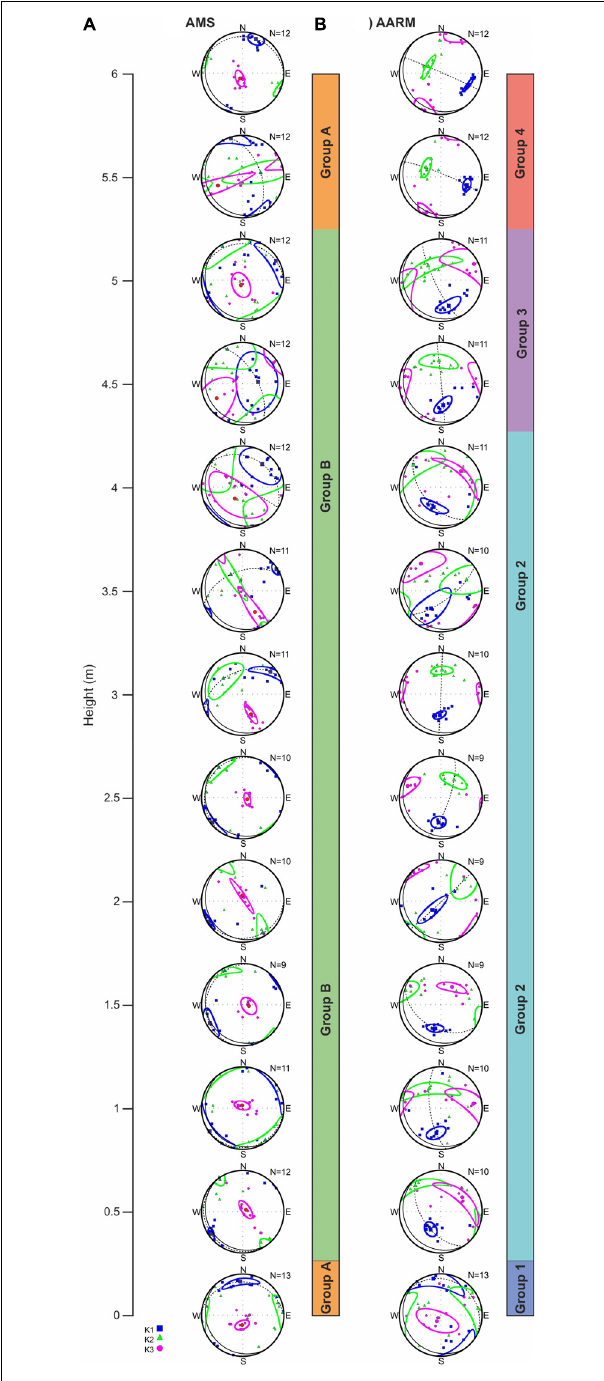
FIGURE 6 | Equal area plots showing (A) AMS measurements and the location of two AMS groups and (B) AARM measurements and the location of four AARM groups at different heights across the crinanite sill thickness. The number of specimens (N) used for each technique at each height is shown in the upper right of each plot. For all plots the K 1 axes are blue squares, K 2 axes are green triangles and K 3 axes are purple circles, and the colored solid lines are their respective 95% confidence ellipses. The solid black line represents the sill plane and the dashed black line represents the magnetic foliation